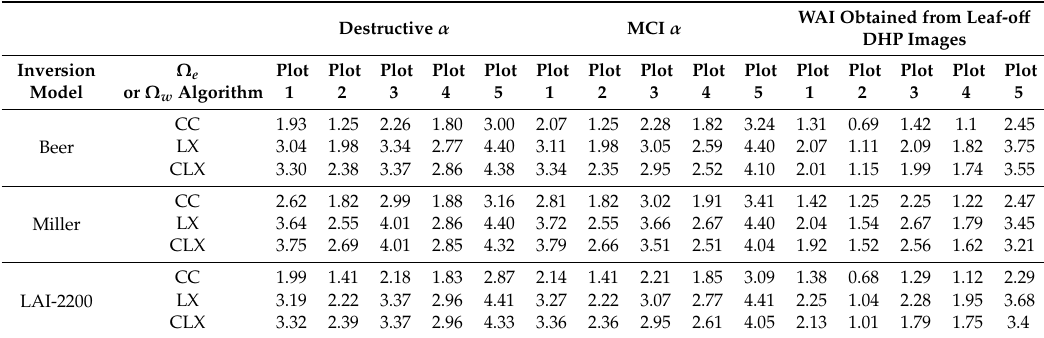
Table 4. LAI derived from the leaf-on DHP images using the three canopy element or woody components clumping index ( Ω e and Ω w ) algorithms, three inversion models and destructive or MCI woody-to-total area ratio ( α ) or WAI obtained from the leaf-o ff DHP images in the five plots. WAI Obtained from Leaf-o ff Destructive α MCI α DHP Images